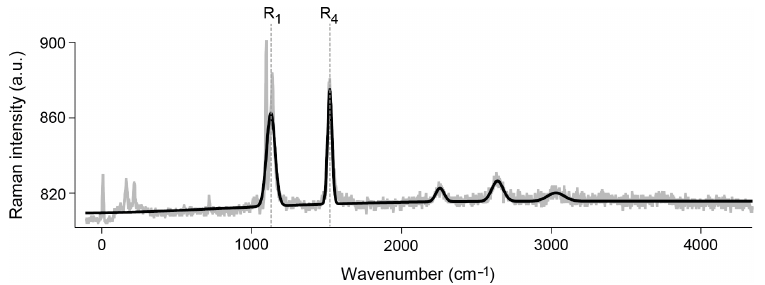
Figure 3. Raman spectrum of Arctica islandica showing the typical aragonite peaks (gray line). The exact position of the polyene peaks R 1 and R 4 was determined by using a peak fitting routine based on a Gaussian function (black